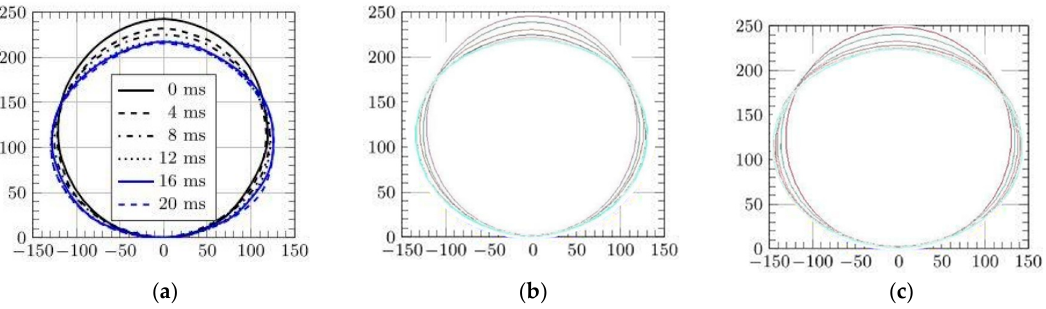
Figure 11. Deformation of the cylinder falling from 500 mm [42]; ( a ) experiments, ( b ) without air, ( c ) with air.